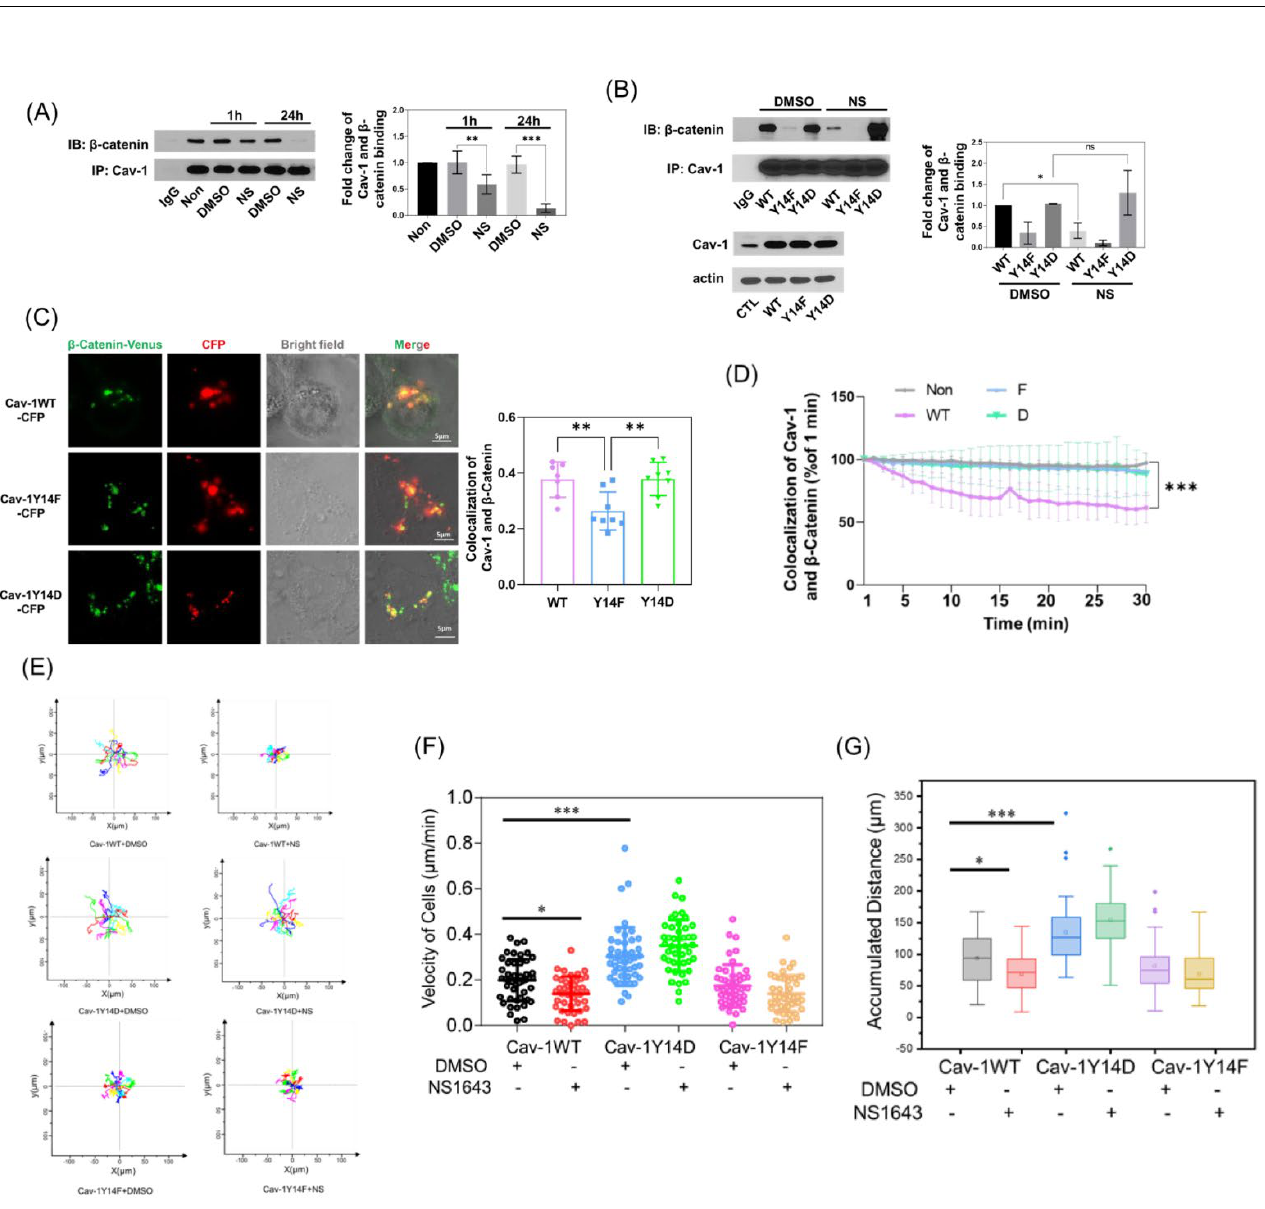
Figure 5. β -catenin interacts with Cav-1 in a phosphorylation-dependent manner. ( A ) MDA-MB-231 cells treated with DMSO or 50 µ M NS1643 for 1 or 24 h were lysed and immunoprecipitated with anti-Cav-1 antibody. The pellets were washed, eluted, and subjected to Western blotting. Results suggest that NS1643 inhibited the interaction between Cav- 1 and β -catenin, n = 3. ( B ) MCF-7 cells were transfected with Cav-1 wild type (WT), phosphodefective Y14F, and phosphomimicking Y14D mutants; and treated with DMSO or 50 μM NS1643 for 1 h. Cells were then lysed and immunoprecipitated with anti-Cav-1 antibody. The beads were then washed and boiled. The eluted proteins were blotted for β -catenin. Co-IP of Cav- 1 and β -catenin was inhibited by NS1643 in Cav-1 WT expressing cells, but not with Y14F mutant, and remained high in Y14D mutant expressing cells, indicating that their interaction is phosphorylation-dependent, n = 3. ( C ) Cav depleted MDA-MB-231 cells were co-transfected with CFP-tagged WT, Y14F, and Y14D Cav- 1 mutants and β -catenin-Venus for 48 h. Live cells were then visualized using confocal microscopy. The colocalization of CFP-tagged Cav-1 mu tants and β -catenin-Venus was reduced in Cav-1Y14F mutant expressing cells, n = 8. ( D ) The colocalization of CFP-tagged Cav- 1 mutants and β -catenin-Venus was assessed using time lapse confocal image sequences for 30 min. The colocalization of Cav- 1 and β -catenin was reduced by NS1643 only in Cav-1 WT expressing cells, n = 6. ( E ) MCF-7 cells transfected with CFP-tagged mutants were treated with DMSO or 50 μM NS1643 and imaged using fluorescence microscopy every 6 min to track the movement of individual cells for 4 h. Image sequences were processed using ImageJ. Representative cell tracks are displayed. ( F ) The motility of cells expressing